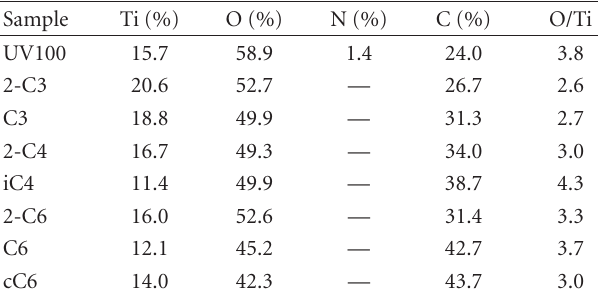
Table 2: The elemental surface composition and atomic ratio of O/Ti resulted from XPS